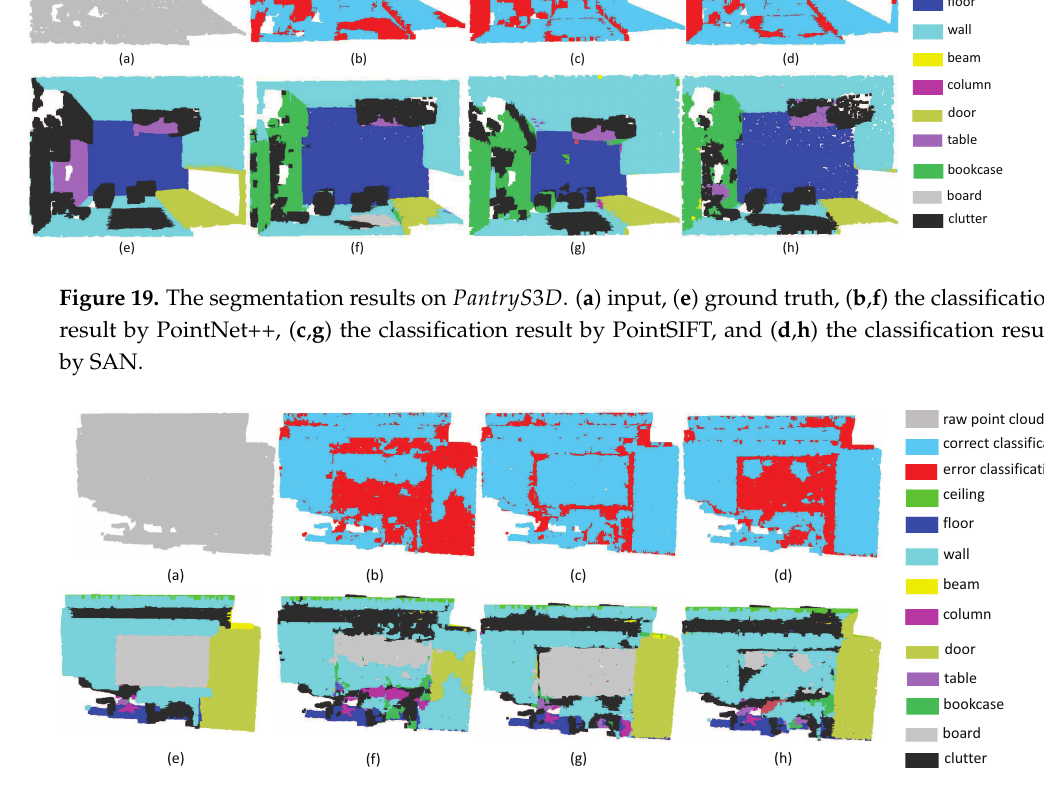
Figure 20. The segmentation results on Of ficeS 3 D 2. ( a ) input, ( e ) ground truth, ( b , f ) the classification result by PointNet++, ( c , g ) the classification result by PointSIFT, and ( d , h ) the classification result by